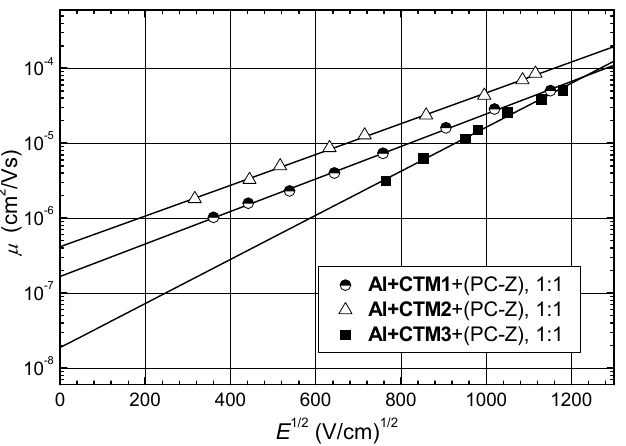
Figure 4. Electric field dependencies of the hole-drift mobilites ( μ ) in charge transport layers of compounds CTM1 – 3 doped in PC-Z (mass proportion 1:1).